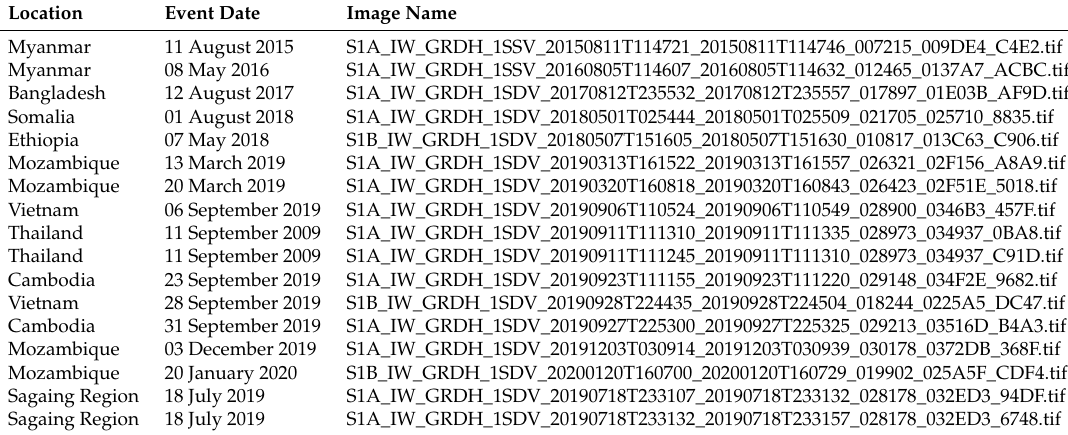
Table A1. Location, event date, image name that can be download from the Copenicus Open Access Hub [53].